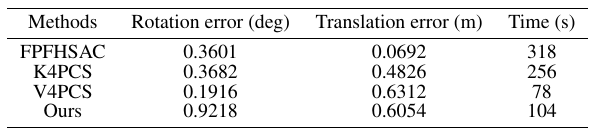
Table 3. Results of four registration methods using the Bremen dataset.